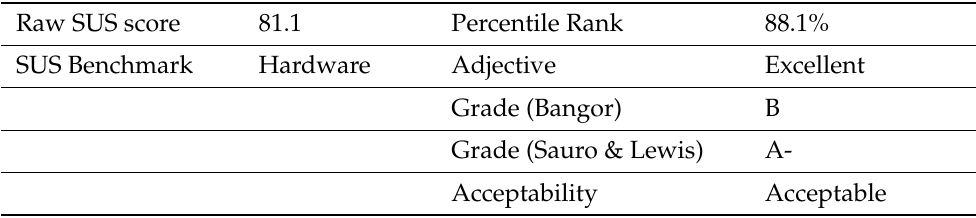
Table 12. SUS results interpretation.